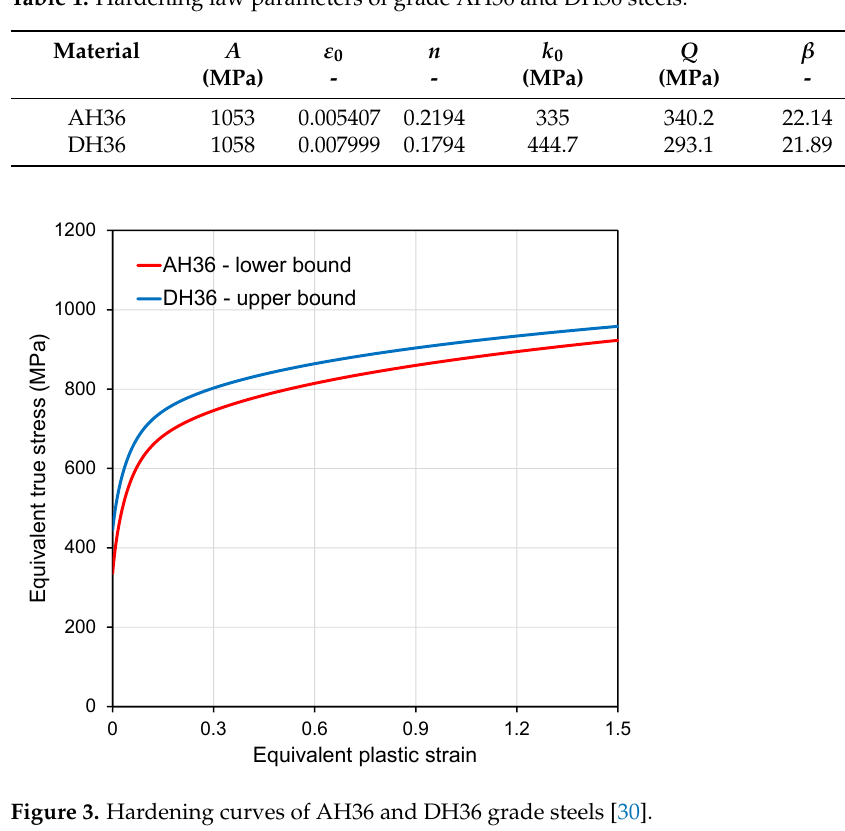
Table 1. Hardening law parameters of grade AH36 and DH36 steels.